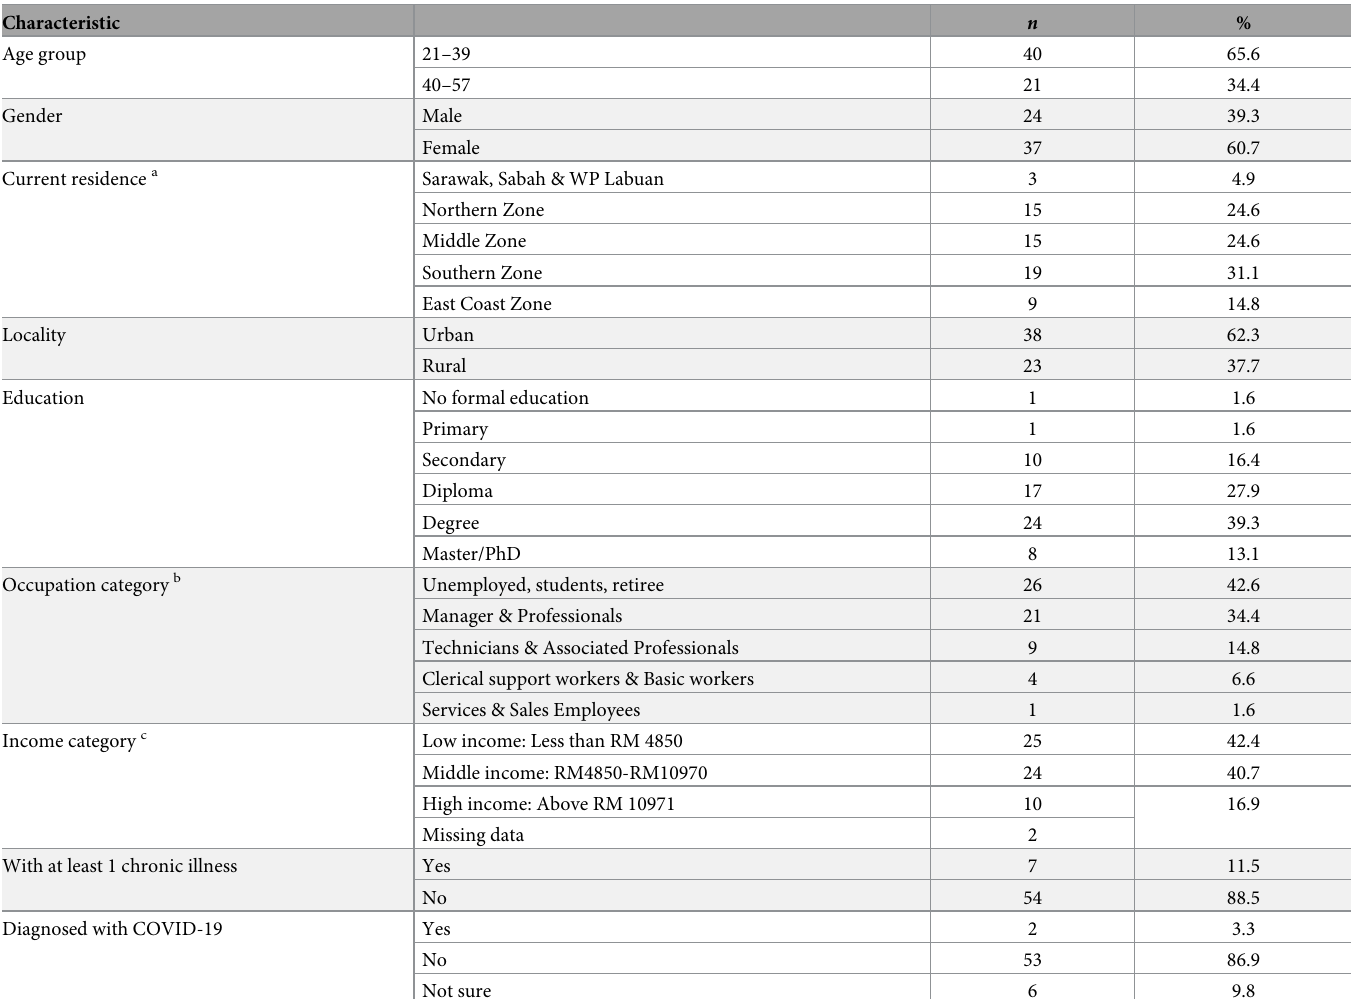
Table 1. Socio-demographic characteristics of respondents ( n =